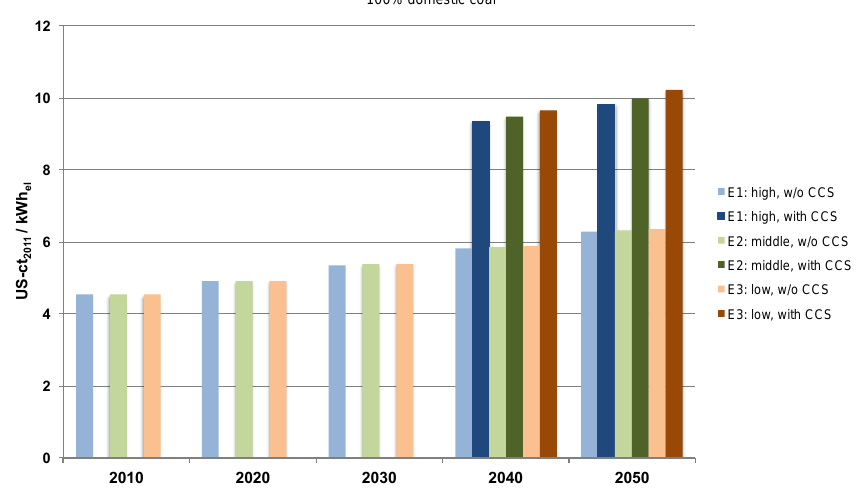
Figure 4. LCOE in South Africa with and without CCS in coal development pathways E1: high–E3: low without CO 2 costs.